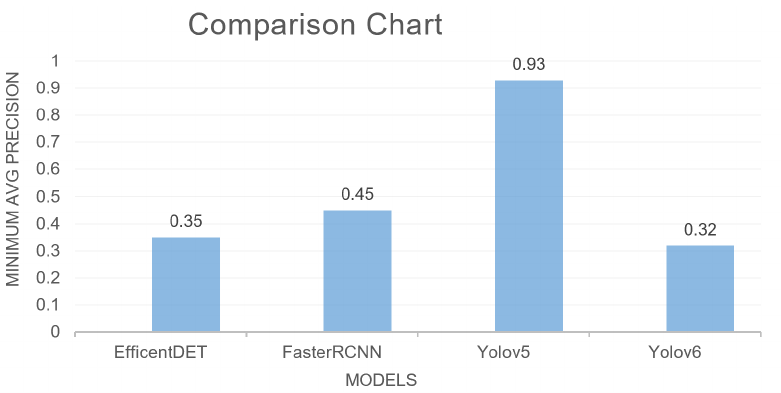
Figure 32. Comparison Chart: Comparative analysis between EfficentDET, FasterRCNN, YOLOv5, and